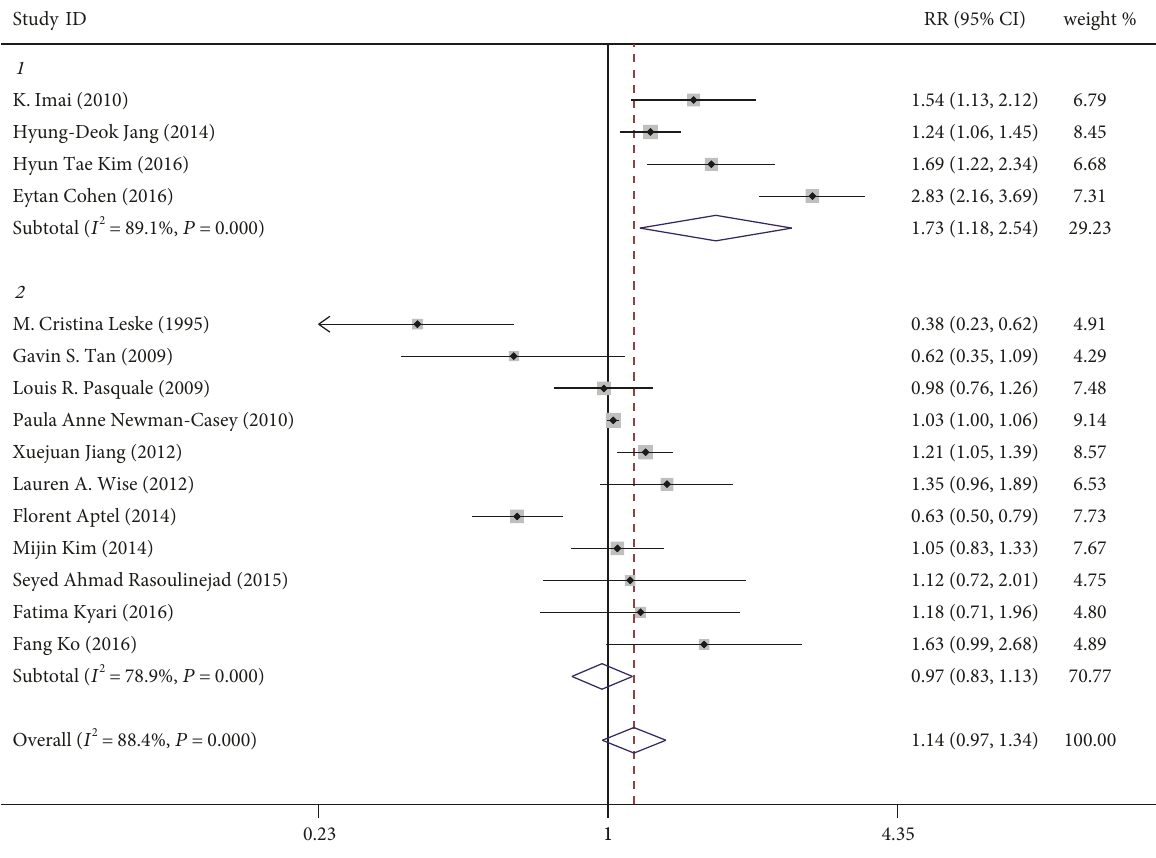
Figure 2: Forest plot for the association between adiposity and elevated IOP or OAG incidence. 1=elevated IOP group; 2=OAG group. Note: weights are from random-e ff ects